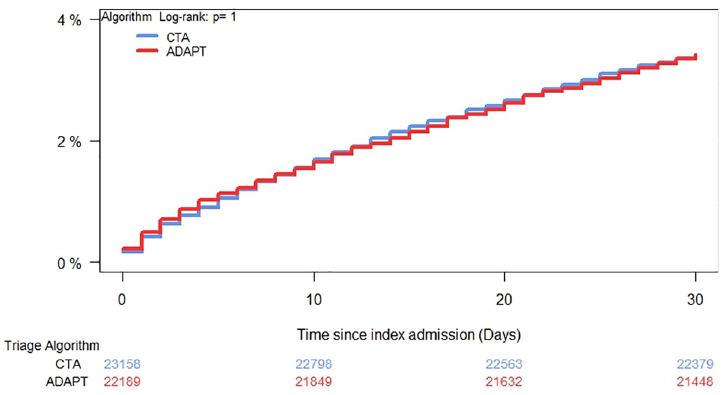
Fig 2. Cumulative incidence plot. 30-day all-cause mortality for patients admitted to the emergency department and triaged with two different systems.